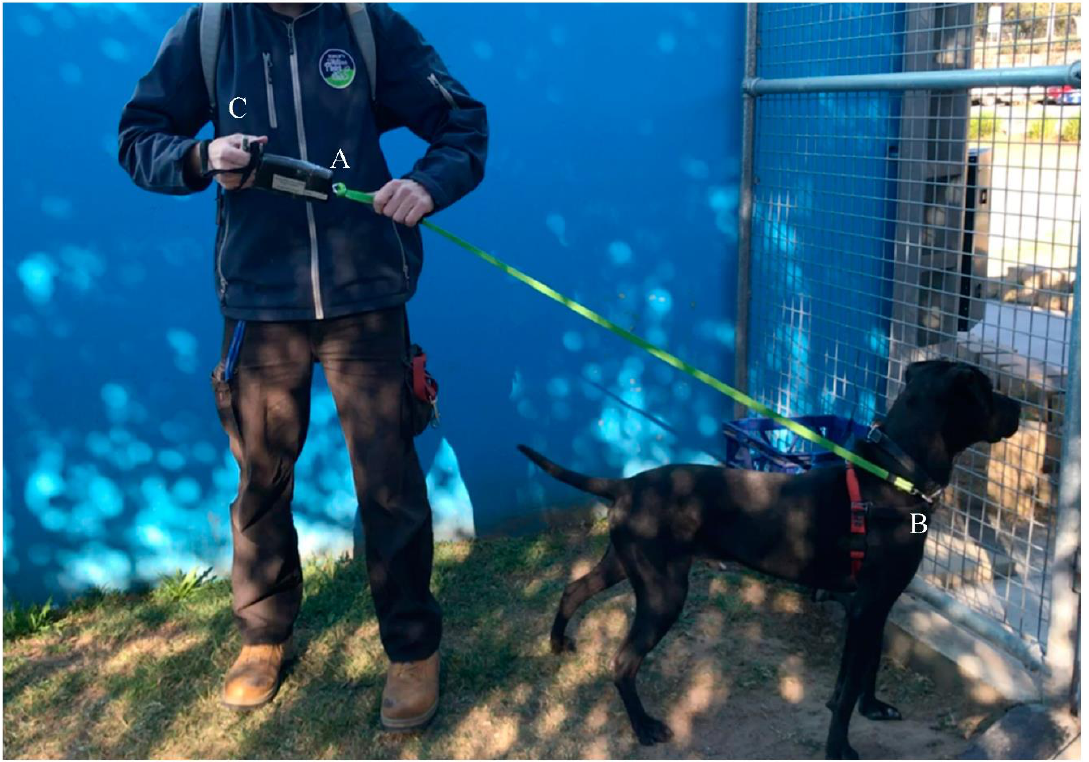
Figure 1. Demonstration of the canine leash tension meter. A l.4-metre-long leash was connected to the tension meter ( A ) and then was attached to the collar and harness in front of the dog’s chest ( B ). The handler held the metal handle on the other end of the tension meter ( C ).